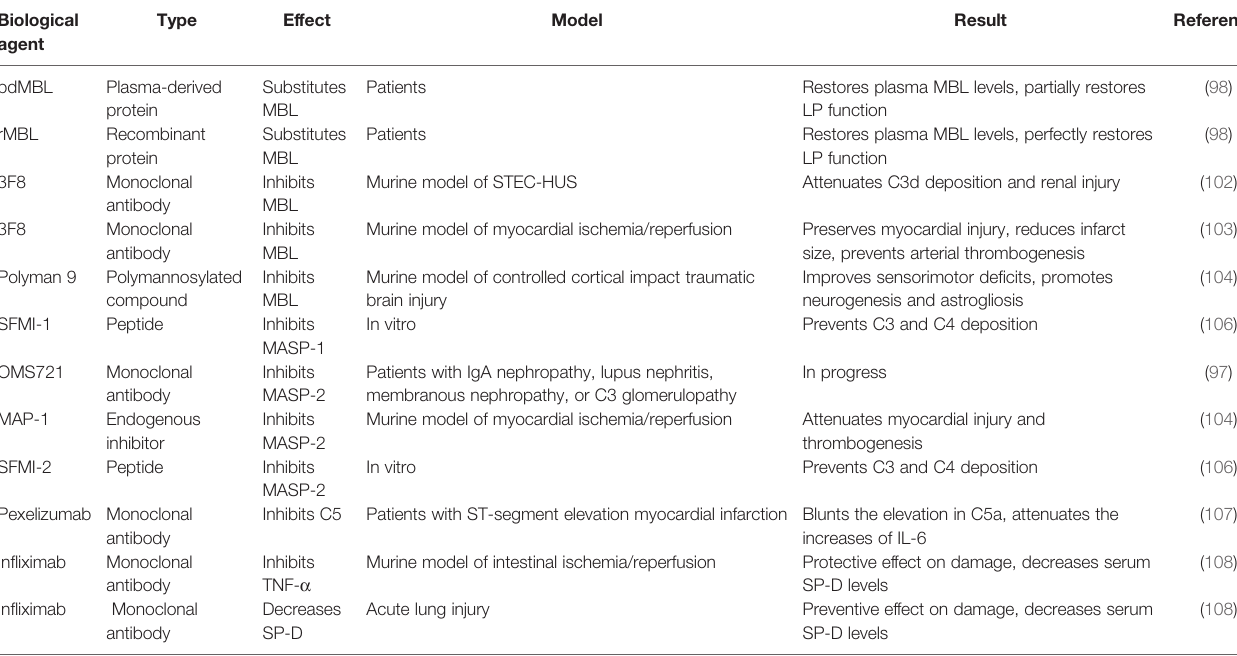
TABLE 1 | Biological agents targeting collectins and relevant